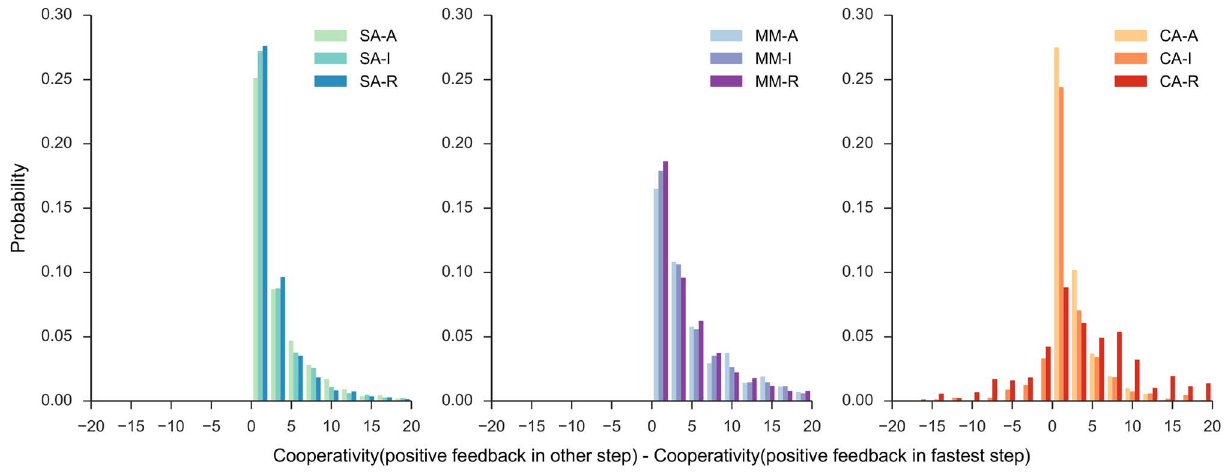
Figure 3. Reduction in the required cooperativity among positive feedbacks within each class. For each class, the additional reduction achieved in the minimum cooperativity by placing the positive feedback on the fastest step (largest degradation rate or smallest half-life) in the three-component motif, relative to positive feedback elsewhere, is shown as a histogram for the same data in Figure 2. For the class CA, this translates to a positive feedback between the two fastest steps in the core motif. For each choice of parameter values, the motif that happens to have the positive feedback on the fastest step (or between the fastest steps) is compared against the remaining two motifs within each class and labeled with name of the former. We compare different motifs keeping common parameters at identical values using the color scheme used in Figure 2.